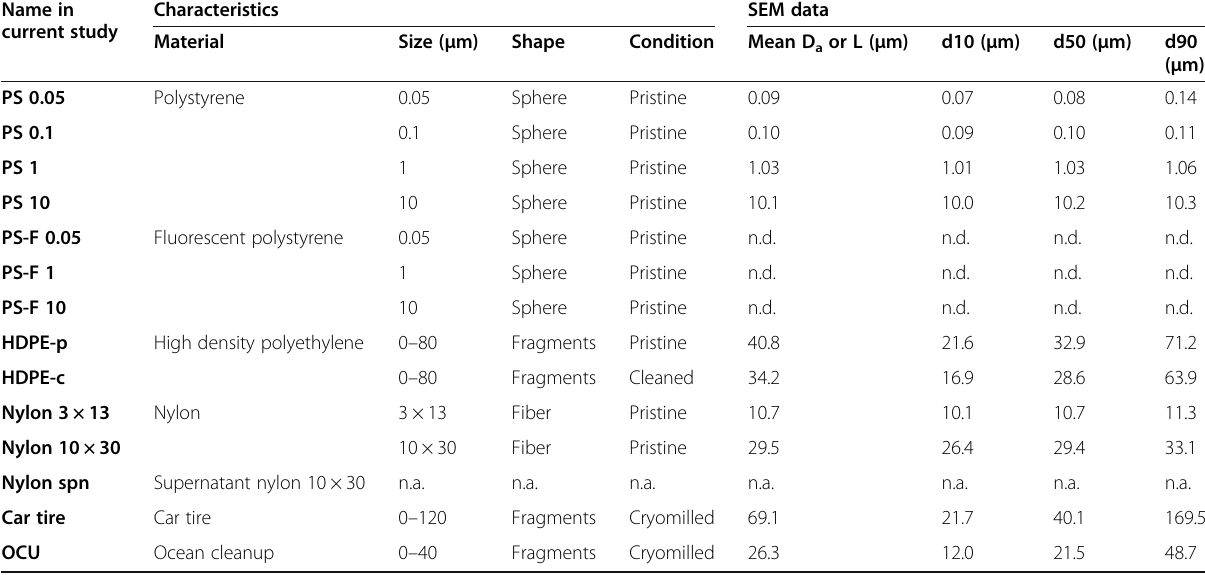
Table 1 Details of the tested MNP. Using SEM, the mean diameter (for spheres and fragments) or length (for fibers) was determined. n ≈ 100